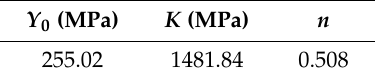
Figure 3. Comparison between experimental and numerical stress–strain curves from the uniaxial tensile test in the rolling direction (stainless steel SS304). Table 1. Material parameters used in the isotropic Swift hardening law to describe the SS304 stainless steel.